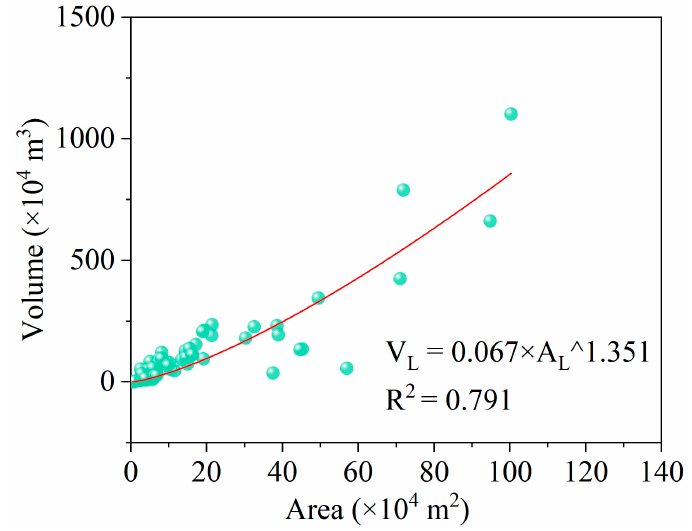
Figure 11. Empirical measurements for landslides of the slide type obtained through a literature search. Dots portray the area, A L ( x -axis, m 2 ), and volume, V L ( y -axis, m 3 ), of 72 landslides. Table 2. Comparison of the landslide areas and predicted volumes in this study with published data [25,66] .